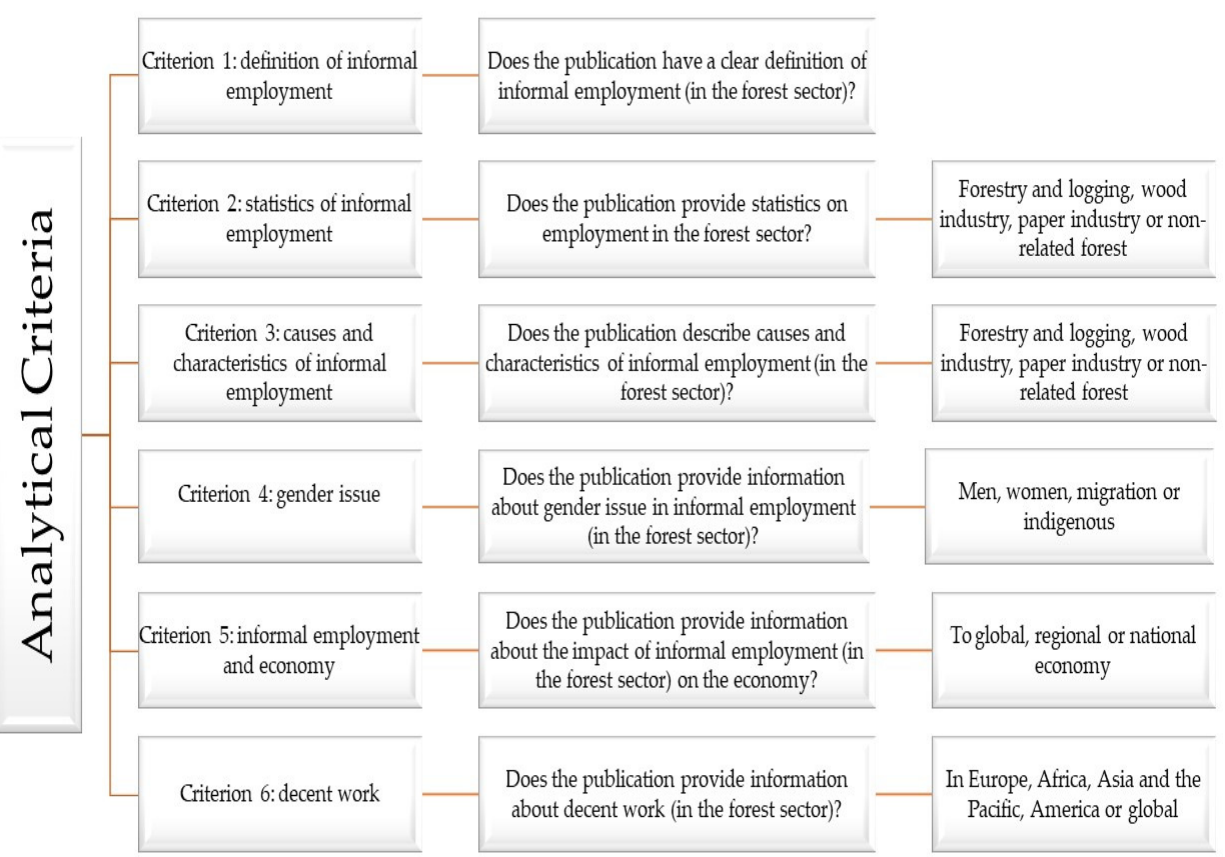
Figure 2. The analytical criteria of literature screening .